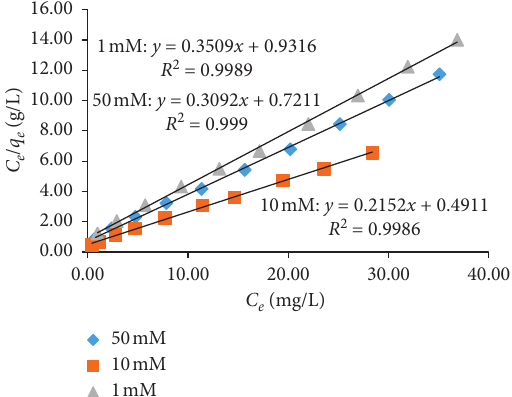
Figure 3: Effect of contact time to the TC removal onto NCPML ( C i (TC) � 10mg/L), pH 4. Error bars indicate the standard de- viations of three